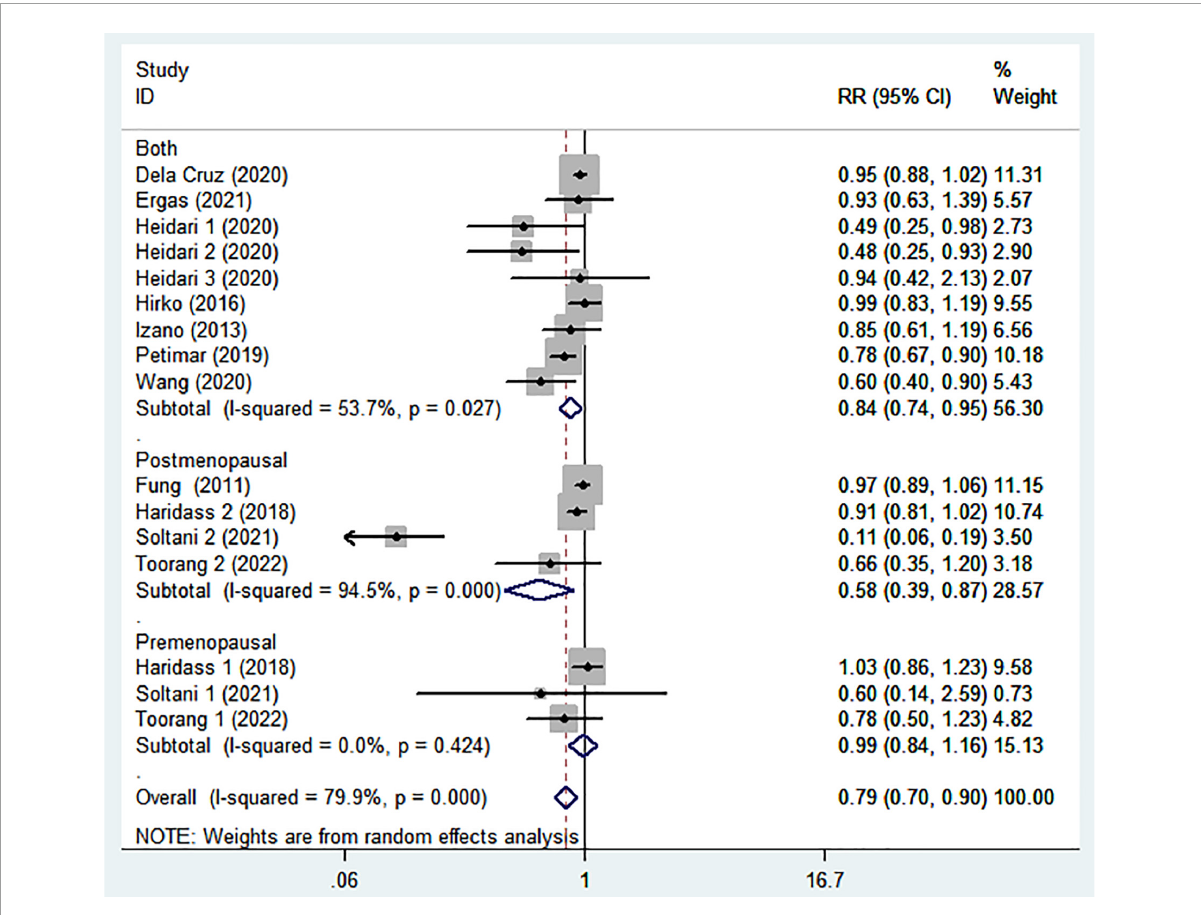
FIGURE5 Meta-analysis on the association between adherence to dietary approaches to stop hypertension (DASH) diet and breast cancer risk stratified by menopausal